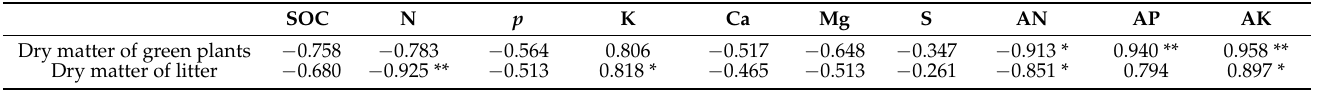
Table 1. Pearson correlation coefficient among soil nutrients and dry matter of green plants and litter. SOC N p K Ca Mg S AN AP AK Dry matter of green plants − 0.758 − 0.783 Note: * and ** show differences at p < 0.05 and p < 0.01, respectively.